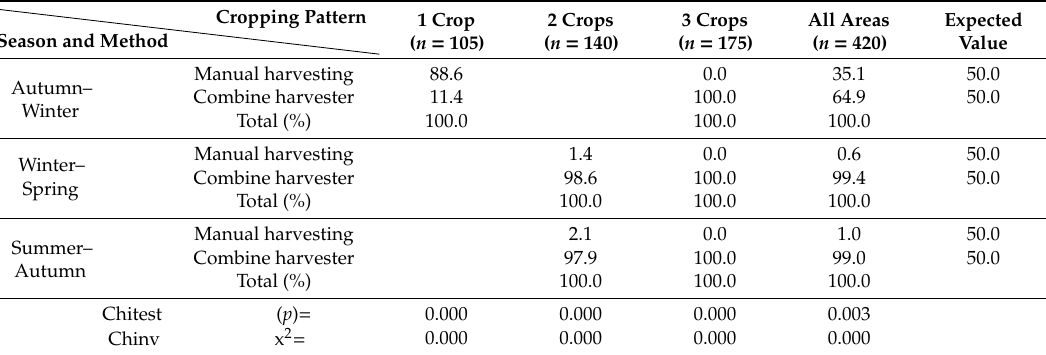
Table 14. Current status of harvesting by cropping pattern and season